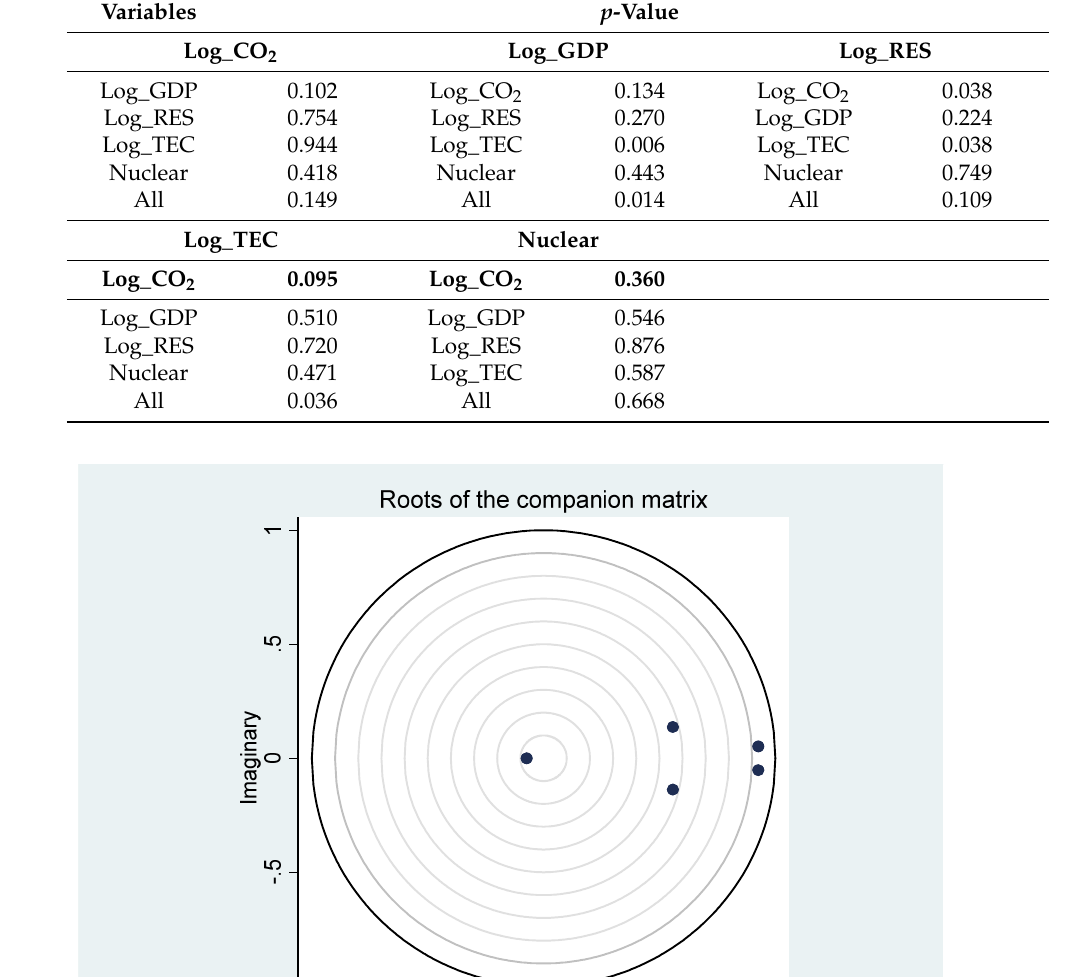
Figure 3. Orthogonalized impulse responses function.